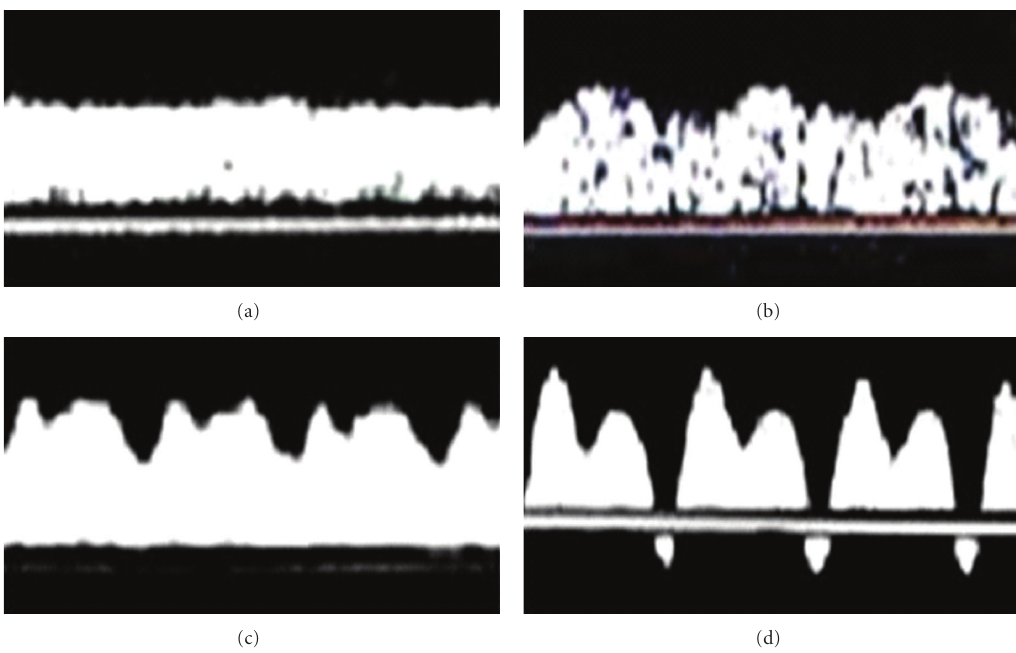
Figure 2: Umbilical venous blood velocity: (a) normal blood velocity, (b) flow with a single pulsation, (c) a double pulsation, and (d) triple-pulsating flow